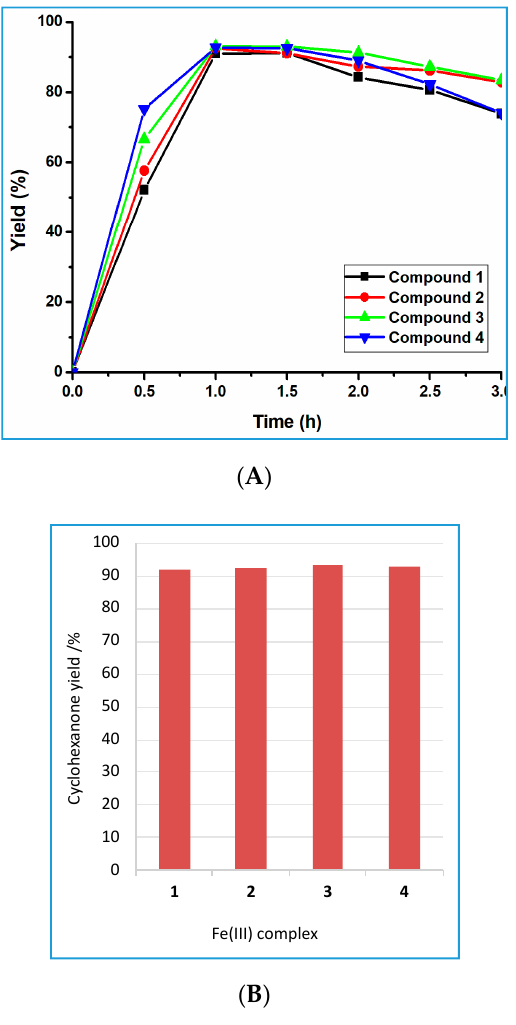
Figure 7. ( A ) Plots of yield vs. time for the microwave (MW)-assisted oxidation of cyclohexanol by tert -butylhydroperoxide catalyzed by frameworks 1–4. ( B ) Maximum yield of cyclohexanone obtained from the same reaction.